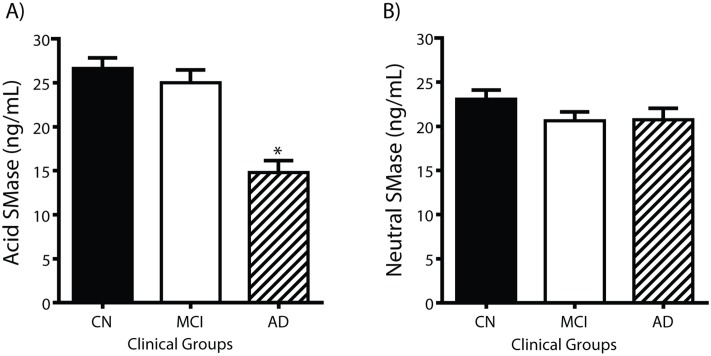
Sphingomyelinase activity decreases in Alzheimer’s disease.aSMase (5A) and nSMase (5B) activities were measured in CSF using fluorescent assays. The data are expressed as the mean ± SEM of the relative fluorescent unit (RFU) per minute using 10 μg protein per assay for CN (n = 70), MCI (n = 40), and AD (n = 29). The asterisk (*) denotes values of P < 0.05 compared with CN.